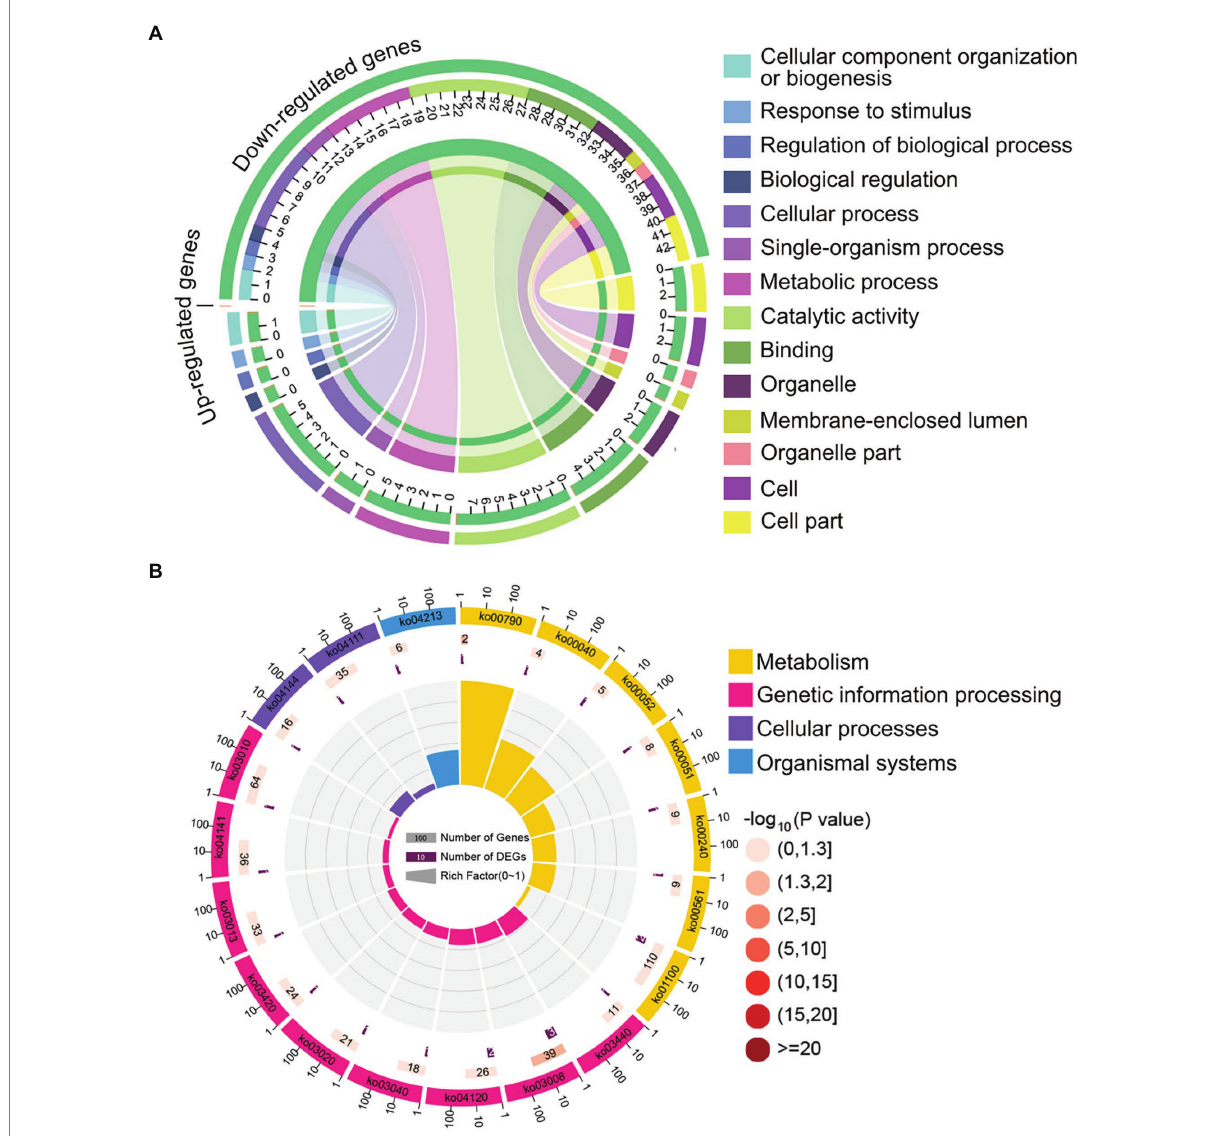
FIGURE 4 Database annotation of shared down-regulated N. ceranae mRNAs targeted by shared up-regulated A. c. cerana miRNAs. (A) GO database annotation of down-regulated mRNAs shared by NcCKm vs. NcTm7 and NcCKm vs. NcTm10. (B) KEGG database annotation of down-regulated mRNAs shared by NcCKm vs. NcTm7 and NcCKm vs.